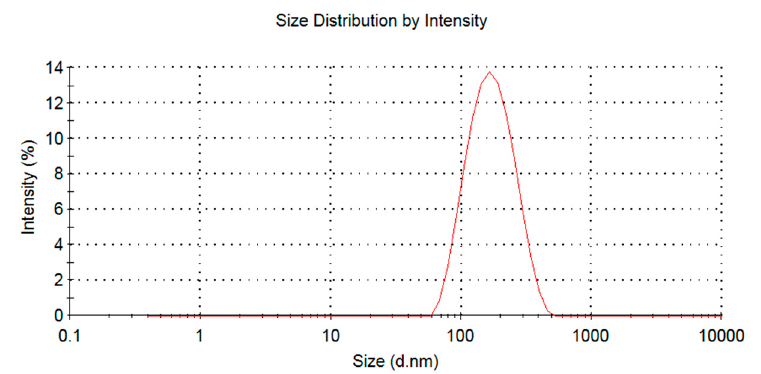
Figure 1. The size distribution of the BA-LP.